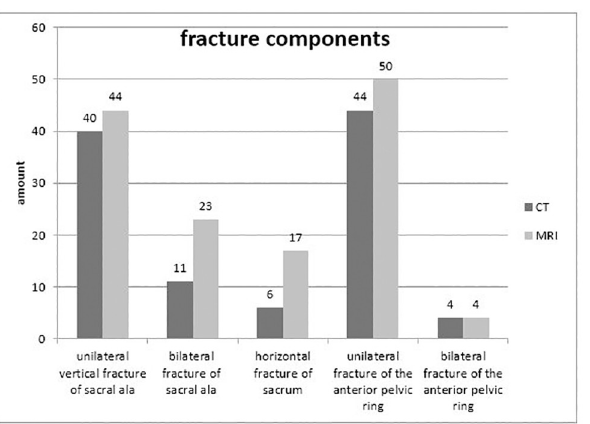
Fig 2. Distribution of the fracture location findings comparing CT with MRI: From left to right: Vertical unilateral fractures (40 vs. 44 patients), vertical bilateral fractures (11 vs. 23 patients), and horizontal fractures (6 vs. 17 patients), unilateral fracture of the anterior pelvic ring (44 vs. 50 patients) and bilateral fracture of the pelvic ring (4 vs. 4 patients).